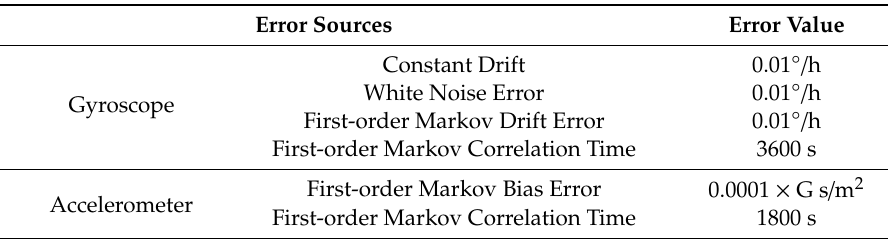
Table 1. Parameters of SINS.